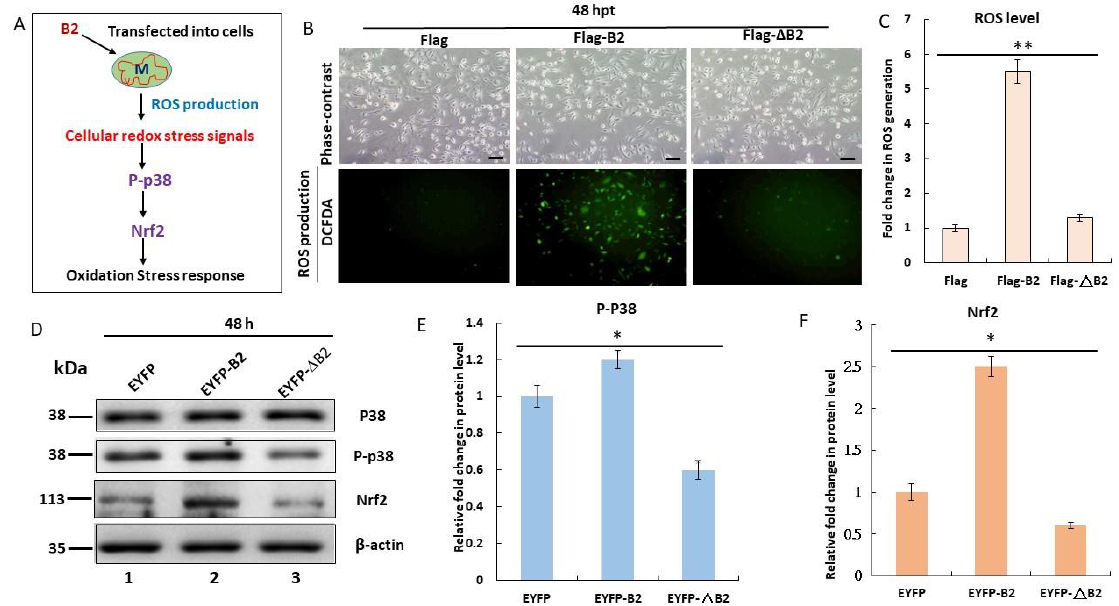
Figure 2. B2 protein causes an ROS/Nrf2-mediated redox oxidative stress signal following mitochondrial targeting in A549 cells. ( A ) Schematic representation of B2-induced, ROS/Nrf2-mediated stress response in A549 cells 48 h post transfection. ( B ) Identification of B2-induced ROS production in different A549 cells transfected with Flag, Flag-B2, and Flag- ΔB2 plasmids. ROS production was traced using the DCFDA method. ( C ) Quantification of ROS production. The data are representative of three separate experiments, and the bars represent the SEMs. * p < 0.05 and ** p < 0.01, as analyzed by one-way ANOVA with Tukey’s multiple comparisons. ( D ) Identification of p38 phosphorylation sites and Nrf2 expression in A549 cells by Western blot analysis. ( E , F ) Quantification of the results in D. The data are representative of three separate experiments, and the error bars represent the SEMs. * p < 0.05 and ** p < 0.01, as analyzed by one-way ANOVA with Tukey’s multiple comparisons.